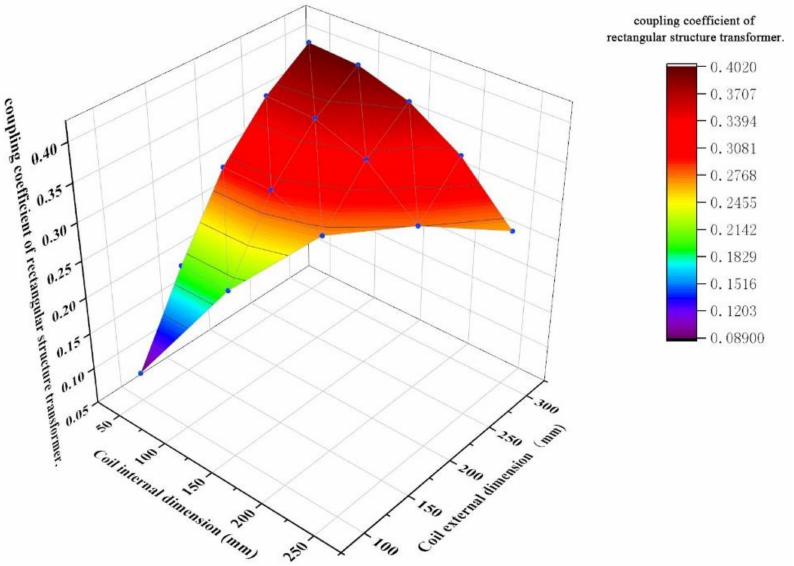
Figure 9. Relationship diagram among the inner and outer diameters of the coil and the coupling coefficient of rectangular structure